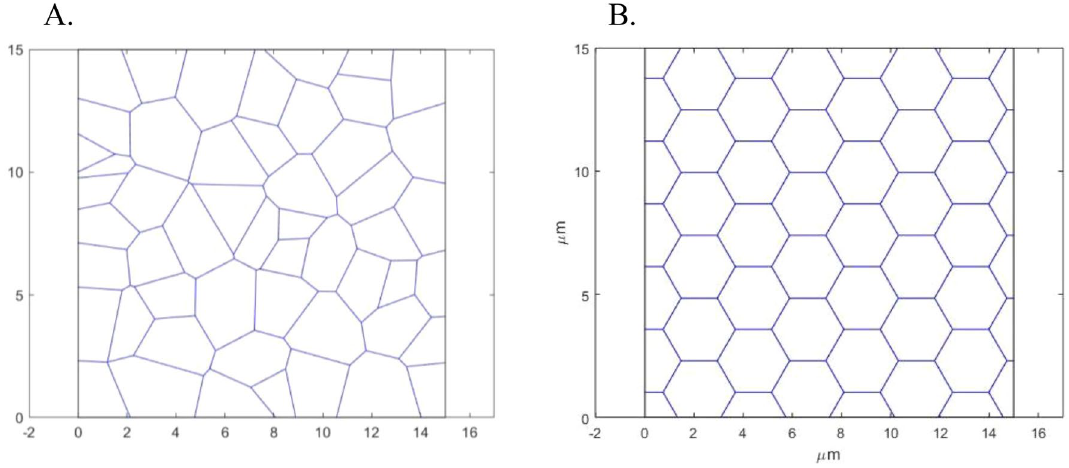
Figure 5. Optimal irregular ( A ) and the corresponding homogeneous hexagonal ( B ) network configurations 1 µm, γ 77 , N M 25 , l c 170 10 3 k B T µm −1 for N = = = = ×